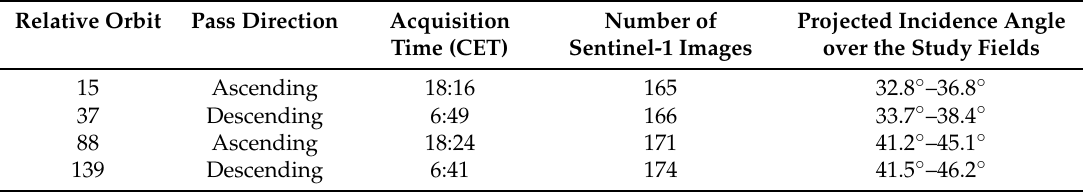
Table 2. Specifications of the Sentinel-1 orbits that cover the Twente